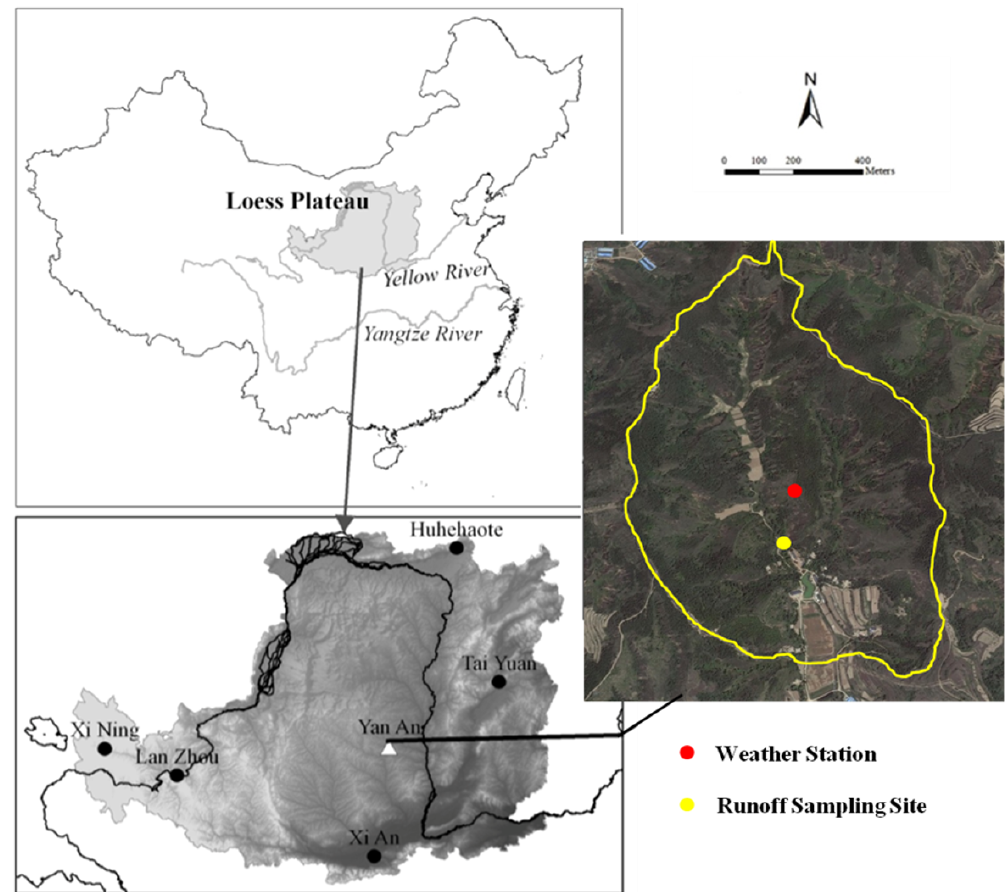
Figure 1. Geographic location of the Yangjuangou catchment in the Loess Plateau region, China; the red and yellow dots denote the weather station and runoff sampling site (source: Wang et al., 2017). Table 1. Characteristics of rainfall amount ( R a ), flow rate, DOC concentration ( C f ) and flux for event-based samples collected during the concentrated rainfall season (June–September